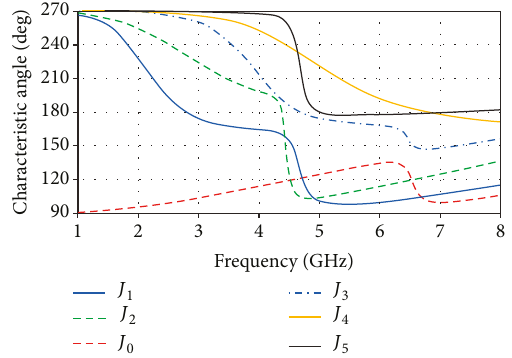
Figure 2: Characteristic angle associated to the fi rst six CM of the patch antenna shown in Figure